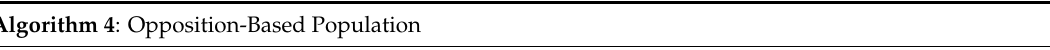
Algorithm 4 : Opposition-Based